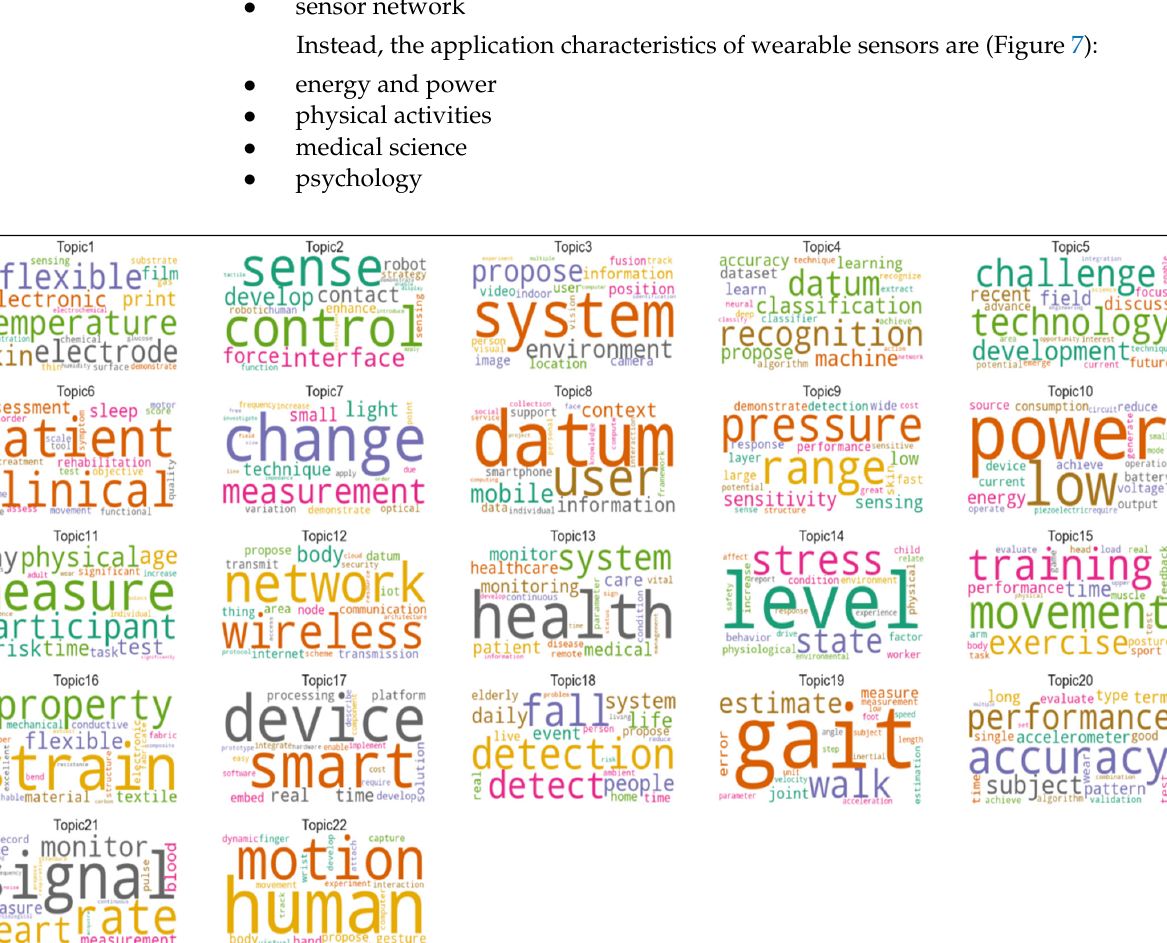
Table 5. Dynamics of trends in wearable sensors using trend analysis.